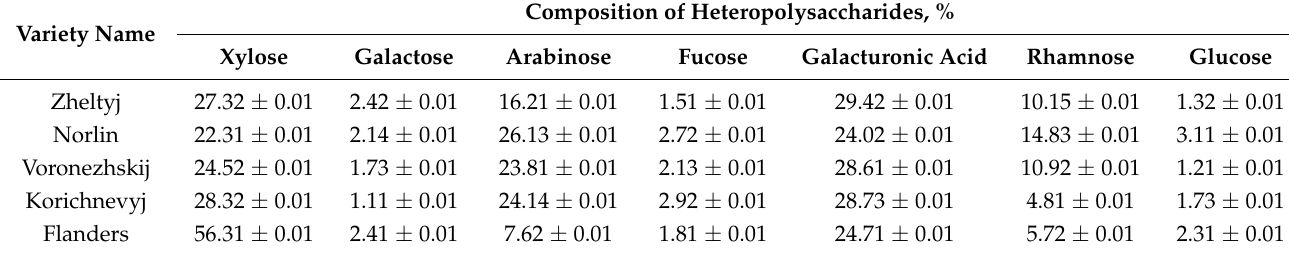
Table 5. Monosaccharide compositions of oil flax mucus samples.